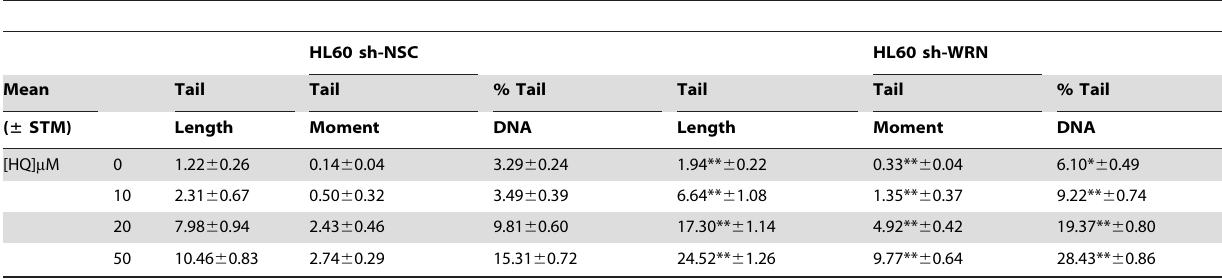
Table 1. DNA damage in HL60 cells treated with HQ for 6 hours analyzed by COMET